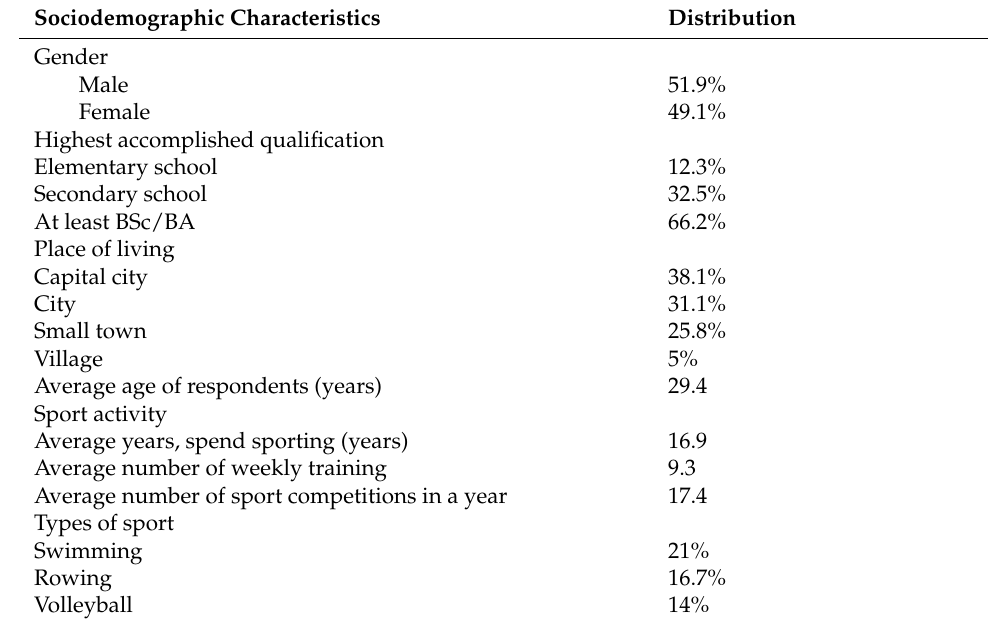
Table 2. Basic sociodemographic characteristics of the